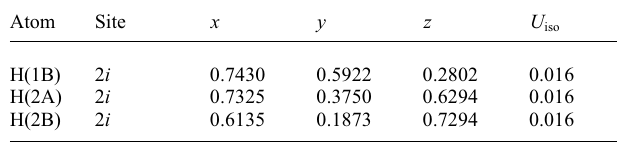
Table 3. Atomic coordinates and displacement parameters (in Å 2 )